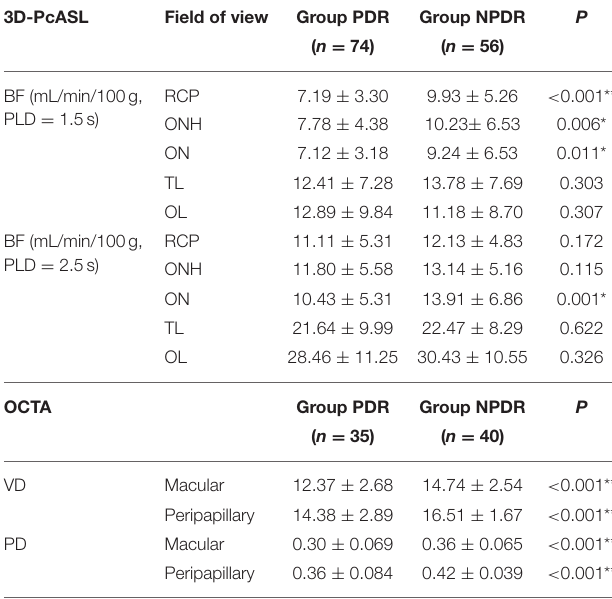
TABLE 2 | BF/VD/PD values of the ocular and optic